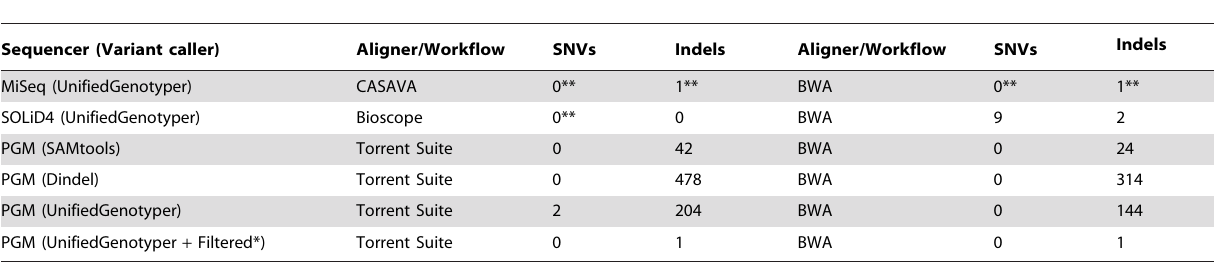
Table 1. Variants in DH10B detected by different platforms and filter